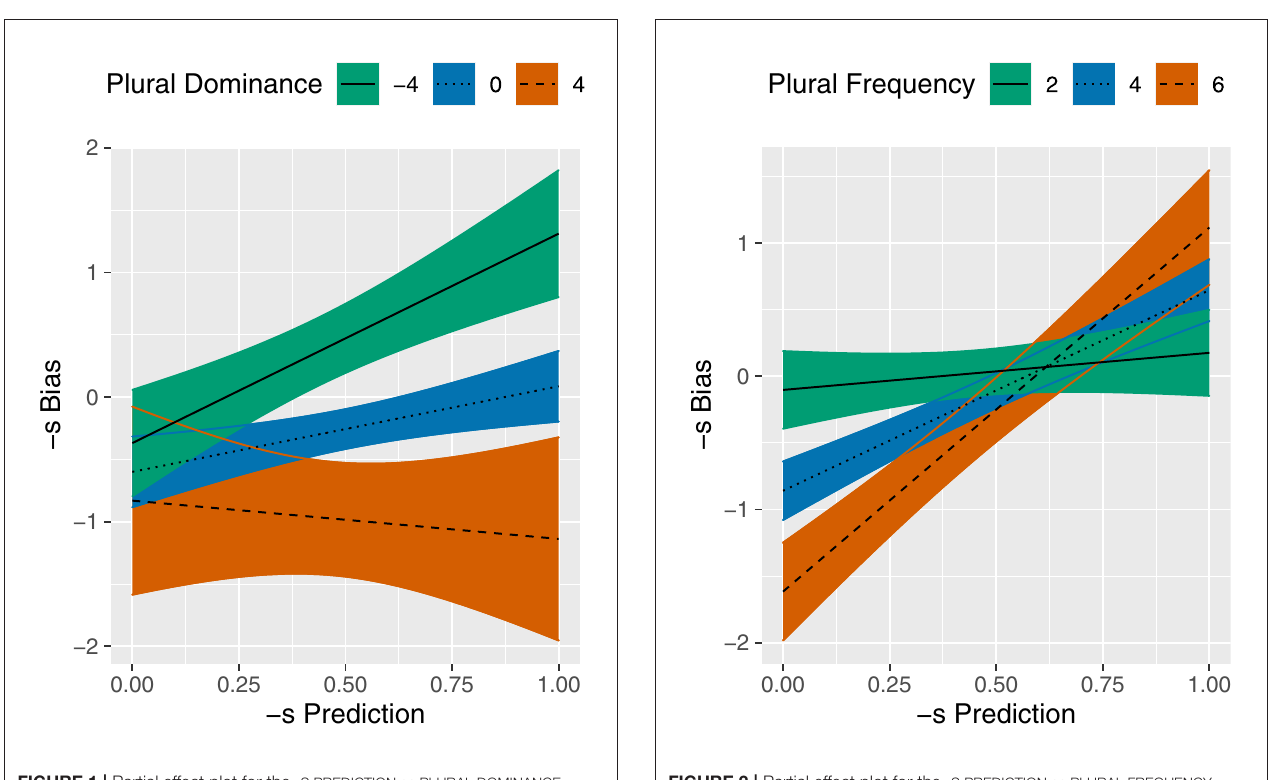
FIGURE 1 | Partial effect plot for the -S PREDICTION × PLURAL DOMINANCE interaction in the model of -S BIAS . PLURAL FREQUENCY is held constant at the median value. Coloured bands reflect 95% confidence intervals.